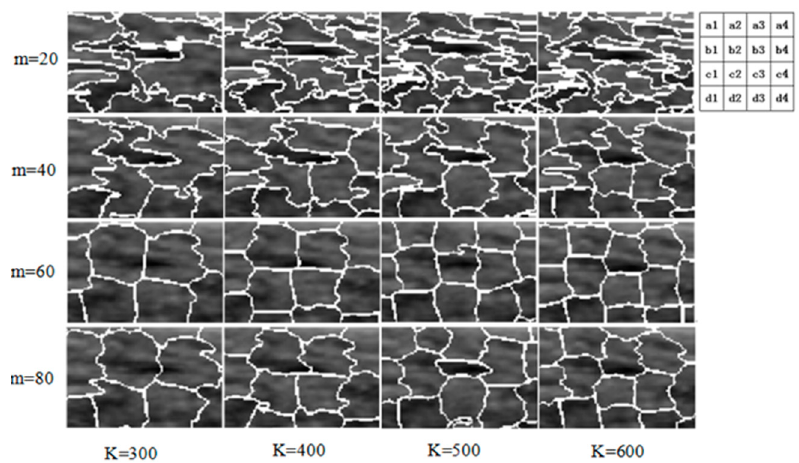
Figure 5. Performance comparison of SLIC with variant K and m of superpixels. These pictures are the superpixel images of a local region in a US breast image. The superpixel segmentation of the original image is shown in Figure 6b.